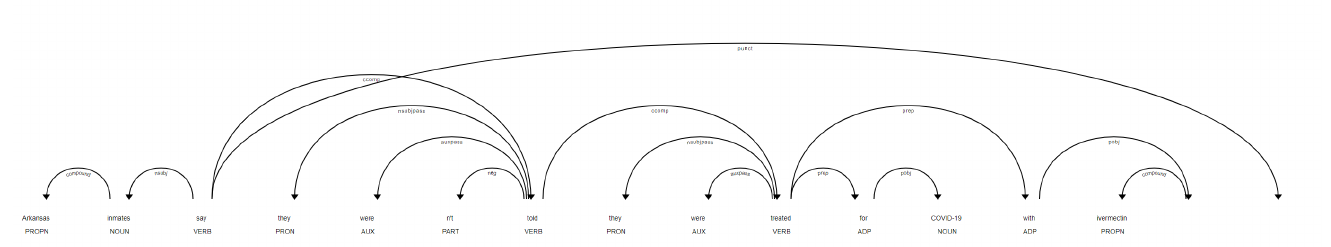
Figure 15. Most followed user’s tweet (positive). The time period stands between 2 September 2021 and 4 September